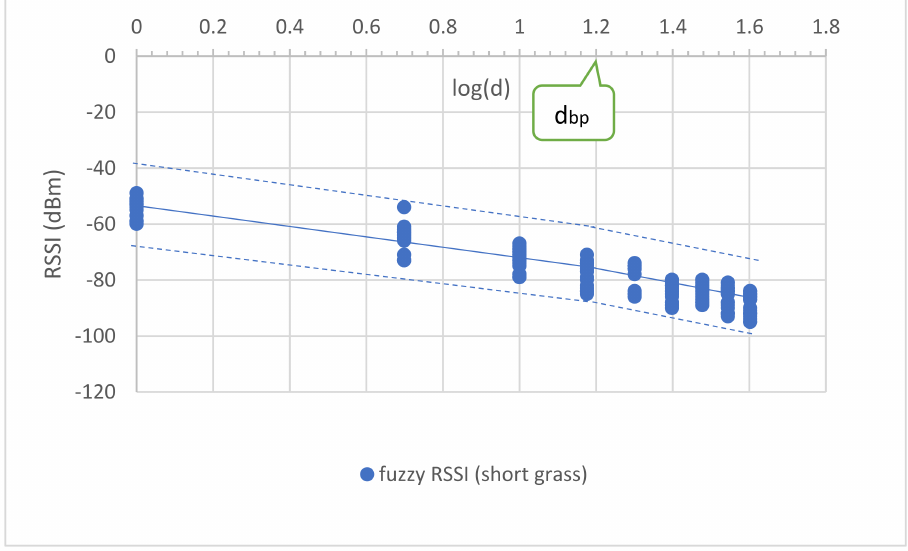
Figure 9. FLR curves for short grass with membership level 0.4.